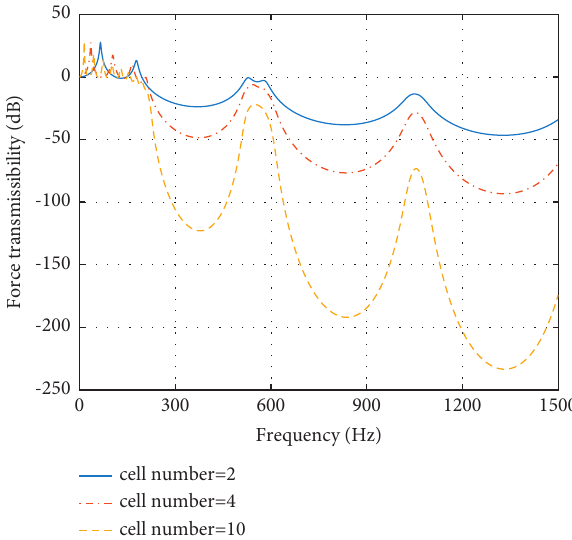
Figure 18: Force transmissibility of PSPS with different periodic numbers under short-circuited.